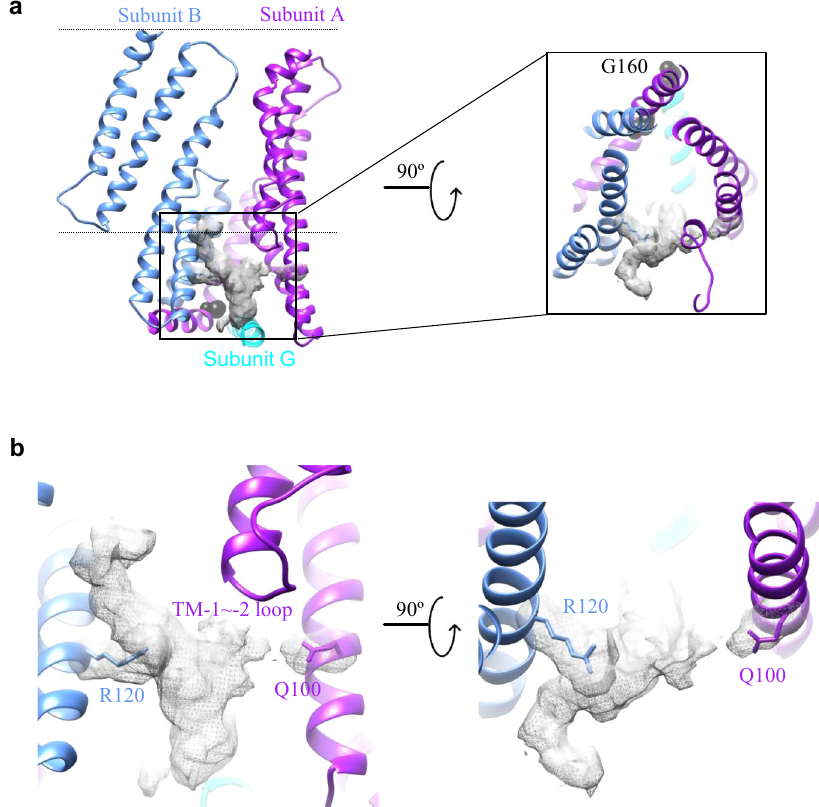
Fig. 3 Lipids accommodated in the pockets between paddle domains. a The cone-shaped pocket formed by three adjacent paddle domains (blue, purple, and cyan) in the membrane (indicated by dashed lines). Within the pocket, there is a bulky lipid density (gray mesh). The kink point in TM3, G160, is shown as black balls. b Zoomed-in views of the lipid density (as boxed in a) in the pocket. R120 and Q100 seem to directly interact with the lipid